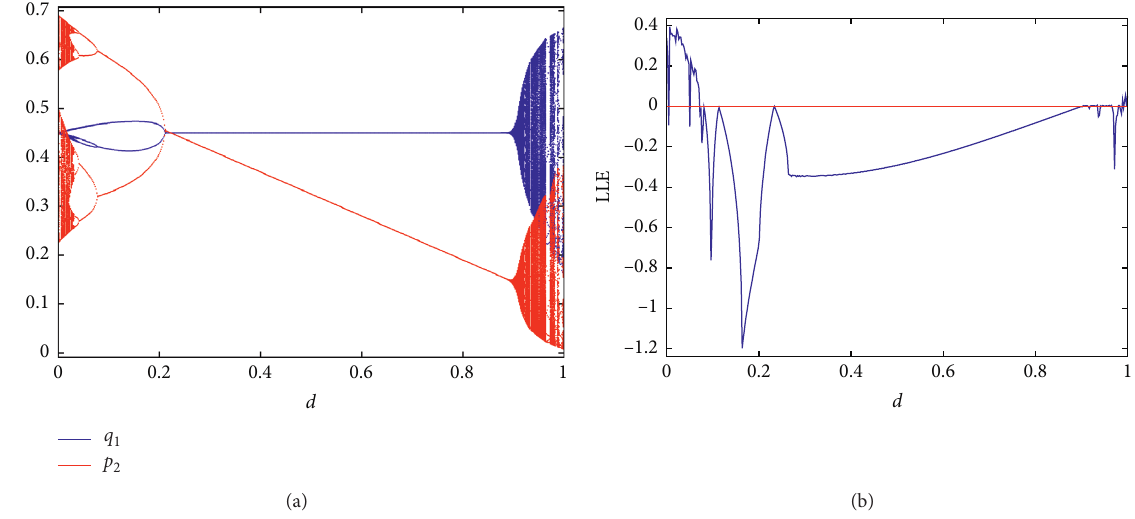
Figure 9: (a) Bifurcation diagram and (b) LLE with respect to d when α � 1 . 5and β � 2 .